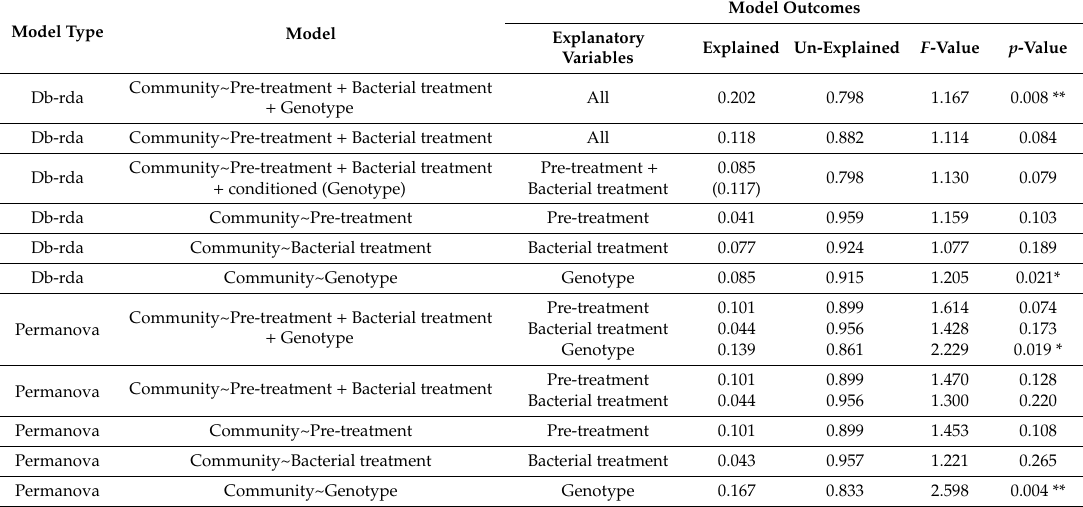
Table 2. Outcomes of models testing the relationship between bacterial community composition in the gut of earthworms sampled at ‘bacterial challenge day 2’ and di ff erent combinations of explanatory variables. Db-rda: distance based redundancy analysis using Bray–Curtis distance matrix and applying square root transformation and Wisconsin double standardization. Permanova: Permutational multivariate analysis of variance using Bray–Curtis distance matrix and 999 permutations. ‘Explained’ and ‘Unexplained’ represent in db-rda models the proportion of inertia either explained or unexplained by explanatory variables. In brackets (in the ‘Explained’ column), the fraction of the inertia that is conditioned is shown (i.e., removed). In Permanova models, ‘Explained’ and ‘Unexplained’ refer to the model R 2 and residual R 2